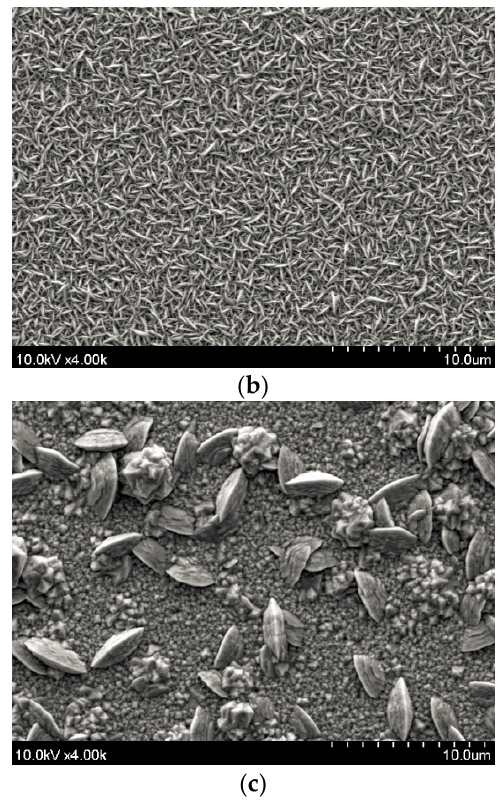
Figure 4. Surface morphology of the BiTe deposition potentials: ( a ) − 40 mV; ( b ) 20 mV; and ( c ) 60 mV.